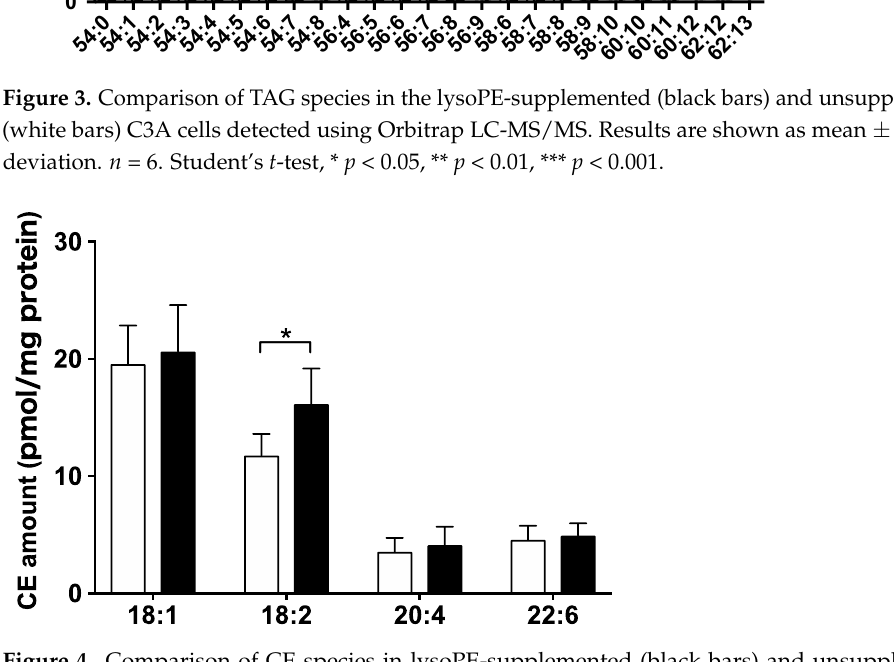
Figure 4. Comparison of CE species in lysoPE-supplemented (black bars) and unsupplemented (white bars) C3A cells detected using Orbitrap LC-MS/MS. Results are shown as mean ± standard deviation. n = 6. Student’s t -test, * p < 0.05.